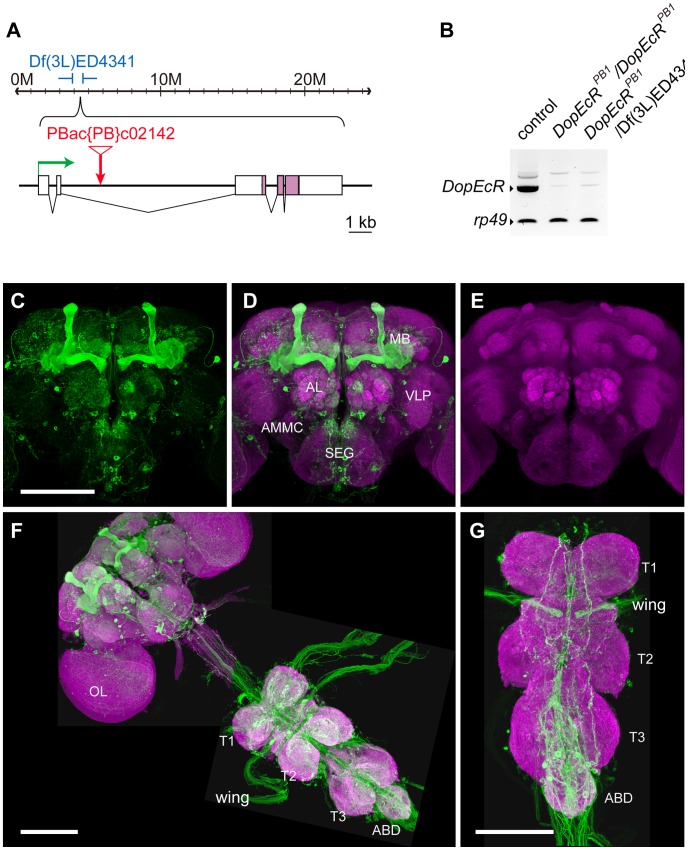
A DopEcR hypomorphic allele and the DopEcR-Gal4 expression pattern.(A) Schematic representation of the Drosophila DopEcR gene. DopEcR contains 5 exons and spans a 12.7 kb genomic region in the 64B2-64B3 cytological interval (Flybase). The DopEcR exons are represented by boxes, and the coding regions are indicated with purple color. A green arrow indicates the direction of transcription of DopEcR. The DopEcR locus is completely uncovered by deficiency Df(3L)ED4341. The PBac(PB)c02142 (DopEcRPB1) allele harbors an insertion of the piggyBac transposable element within the second intron. The insertion site is indicated as a red arrow with an inverted triangle. (B) DopEcR transcript levels in DopEcRPB1 homozygotes and trans-heterozygotes, as assessed by RT-PCR analysis. (C–G) Expression of the GFP reporter gene (UAS-CD4-tdGFP [70]) driven by DopEcR-Gal4 (green) and synaptic neuropil labeled with the nc82 antibody against presynaptic marker protein Bruchpilot (magenta). Anterior view of the adult brain displaying DopEcR-Gal4 expression pattern (C) and the nc82 staining (E). A merged image is shown in (D). (F) Adult brain with the thoracicoabdominal ganglion (ventral view). (G) Dorsal view of the thoracicoabdominal ganglion. Scale bars represent 100 µm. ABD: abdominal ganglion; AL: antennal lobe; AMMC: antennal mechanosensory and motor center; MB: mushroom body; OL: optic lobe; SEG: subesophageal ganglion; T1: prothoracic ganglion; T2: metathoracic ganglion; T3: mesothoracic ganglion; VLP: ventrolateral protocerebrum; wing: wing neuropil.